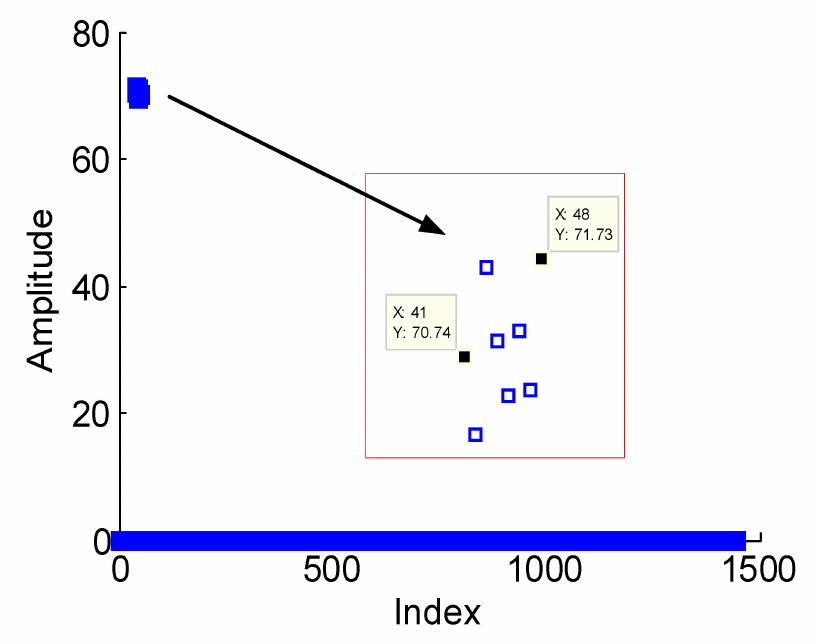
Figure 5. Support position estimation results based on BOMP sparse recovery with the 5 degrees of target’s angle.